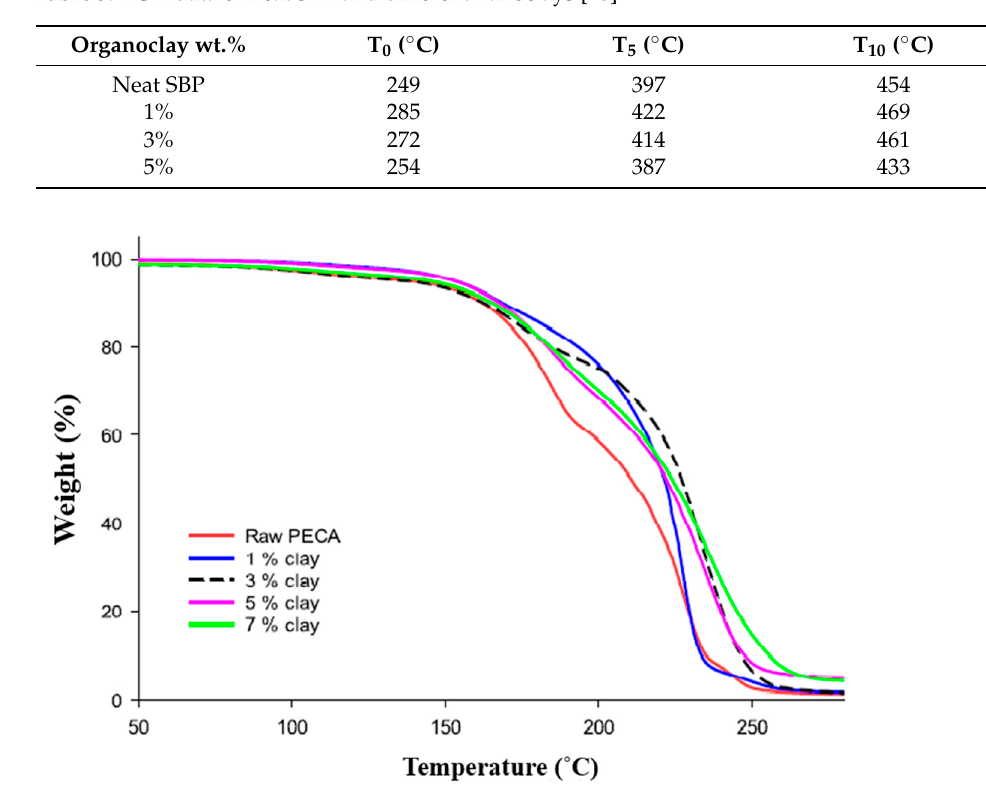
Figure 13. TGA of pure PECA and PECA–modified Mt composites with different wt% [79]. Table 4. Thermal properties of pure PECA and PECA–modified Mt composites with different wt% [79].